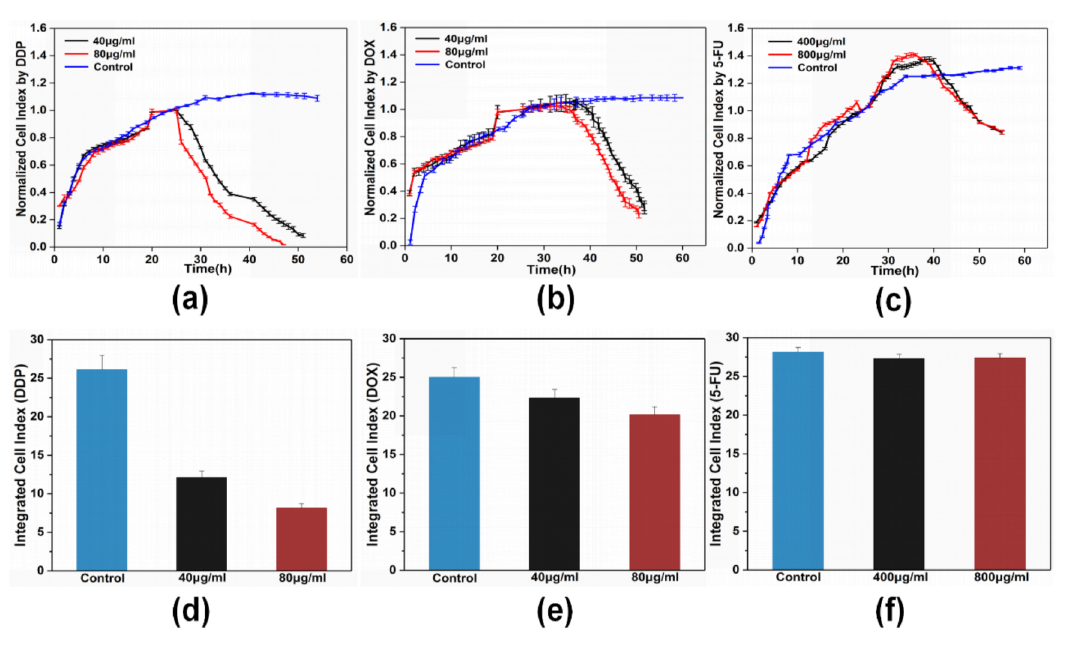
Figure 6. Real-time impedance profiles of HeLa cells treated with ( a ) 40 and 80 µ g/mL cisplatin (DDP), ( b ) 40 and 80 µ g/mL doxorubicin (DOX), and ( c ) 400 and 800 µ g/mL 5-fluorouracil (5-FU). Chemotherapy drugs were added at 24 h. ( d – f ) Time-integrated cell index responses of HeLa cells for drug